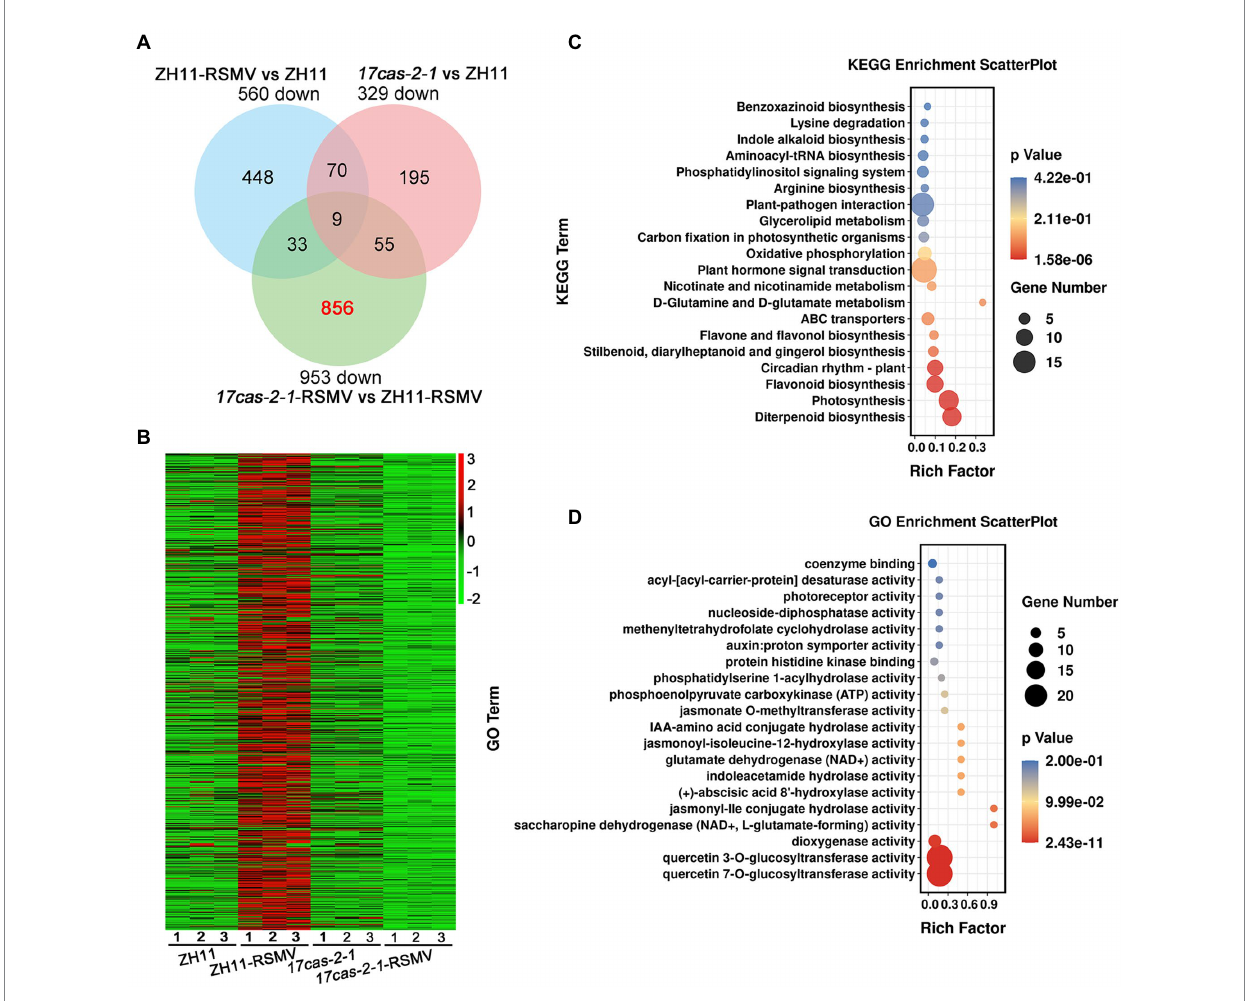
FIGURE 3 Analysis of the 856 of 953 differentially expressed genes (DEGs) of OsARF17-dependent genes were suppressed in 17cas-2-1 -RSMV vs. ZH11-RSMV. (A) Venn diagram illustrating the overlapping of down-regulated 856 DEGs in ZH11–RSMV vs. ZH11, 17cas-2-1 -RSMV vs. ZH11-RSMV and 17cas-2-1 vs. ZH11. (B) Hierarchical clustering of 856 DEGs in (A) based on the log2 fold change in transcript levels in ZH11 and OsARF17 mutant plants under mock or RSMV inoculation. The hierarchical clustering analysis was performed on the FPKM values of all tested genes. (C) KEGG pathway enrichment analyses of 856-down genes (labelled in red) in (A) . (D) Gene ontology (GO) enrichment analysis of 856-down genes (labelled in red) in (A) . “Rich factor” shows the ratio between the number of DEGs and the total genes in this pathway. All differentially expressed genes were selected using cut-off p -value < 0.05 and fold-change > 2 compared with controls. Data were collected from three biological replicates, each containing a pool of three